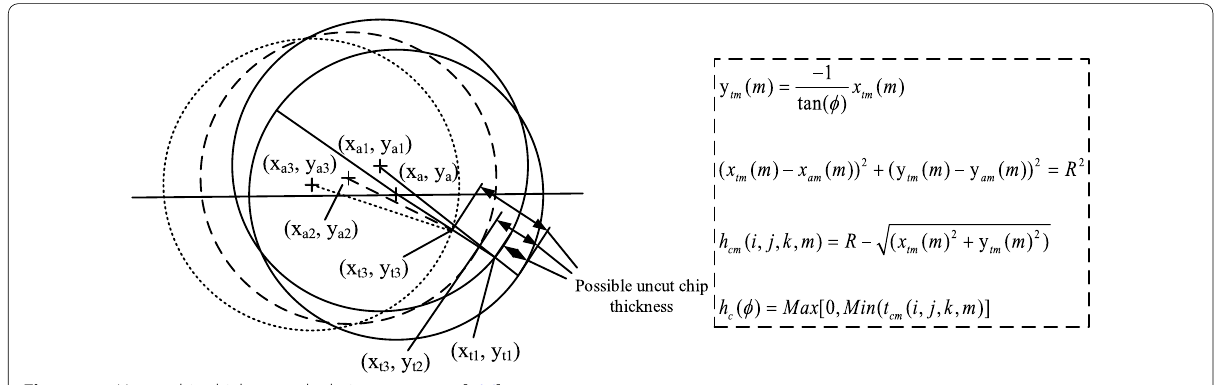
Figure 11 Uncut chip thickness calculation geometry